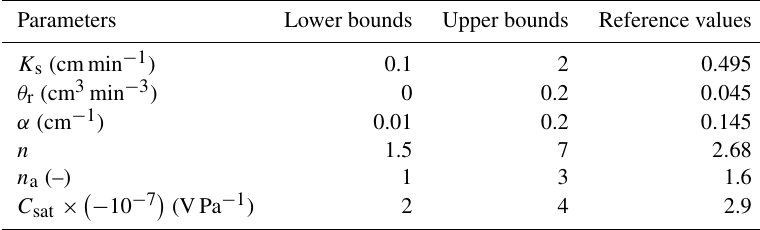
Table 1. Reference values, lower and upper bounds for hydraulic and geophysical